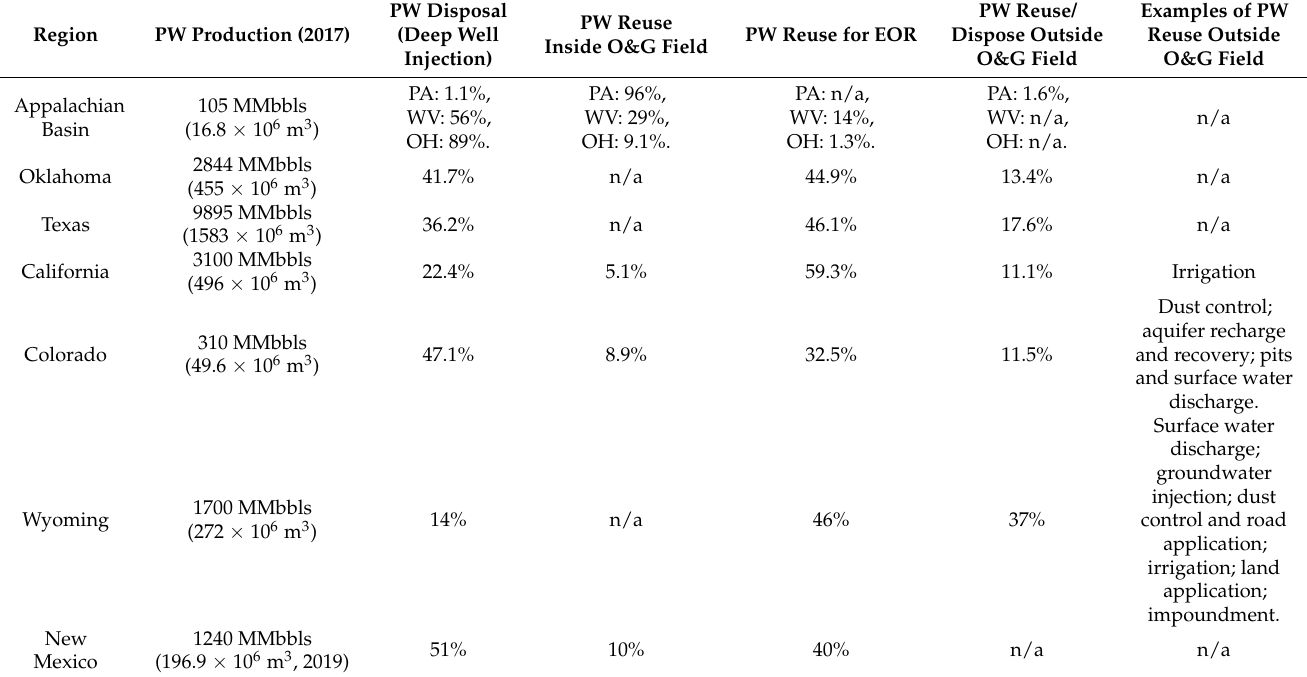
Table 2. Produced water production and management practices in the selected